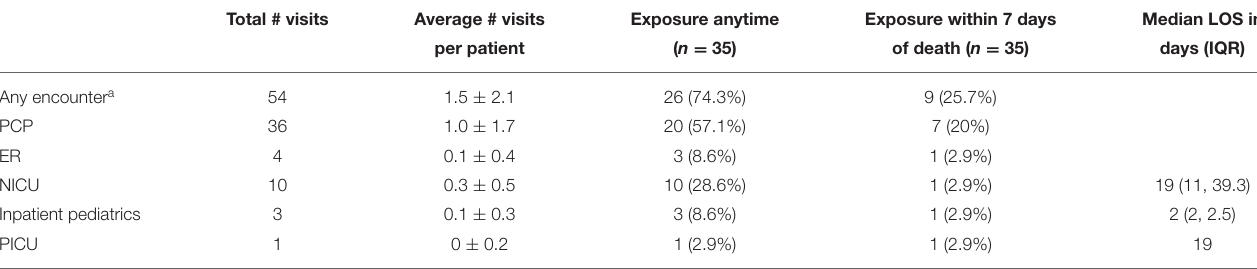
TABLE 3 | Healthcare encounters prior to